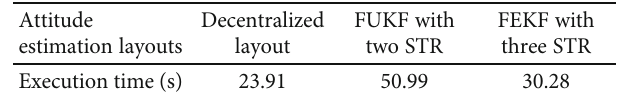
Table 8: Execution time.